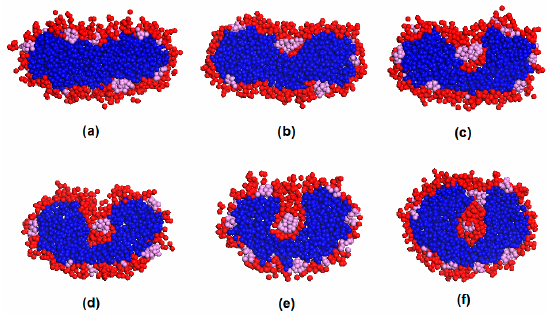
Figure 5. Snapshots for the morphology transition from disk-like micelle to vesicle with a core over the period of 2.8 × 10 5 DPD steps to 3.5 × 10 5 DPD steps. ( a ) 280,000 DPD steps; ( b ) at 290,000 DPD steps; ( c ) at 300,000 DPD steps; ( d ) at 320,000 DPD steps; ( e ) at 340,000 DPD steps; and ( f ) at 350,000 DPD steps. The blue, red, and pink colors represent E, O, and F, respectively, while solvent molecules are omitted for clarity.